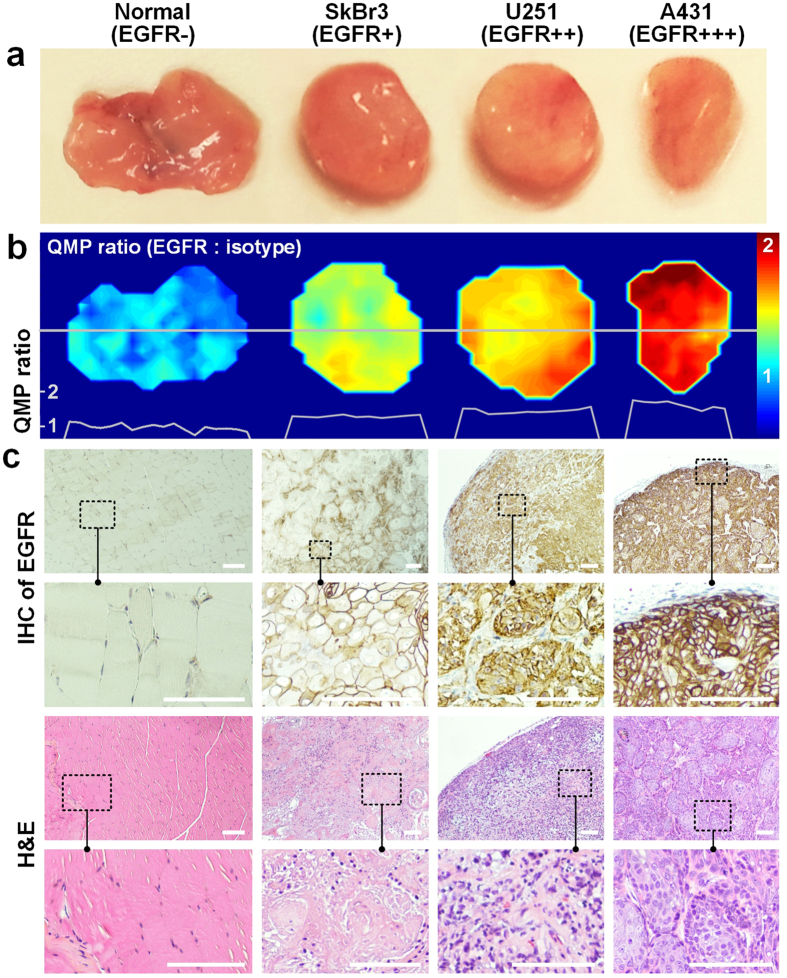
QMP imaging of normal tissue (EGFR-negative) and tumor xenografts (SkBr3, U251, and A431) that express various levels of EGFR.The tissues were stained with a two-flavor NP mixture (EGFR-NPs and isotype-NPs) and the staining-and-imaging procedure was achieved in less than 15 min. (a) Photographs of resected normal tissue (muscle) and tumor xenografts. (b) QMP images of the concentration ratio of EGFR-NPs vs. isotype-NPs. The line profiles at the bottom of the image indicate the QMP ratios along the gray line through the center of each tissue specimen. (c) Validation data: IHC for EGFR (10X and 40X views), and H&E staining (10X and 40X views). The scale bars represent 100 μm.